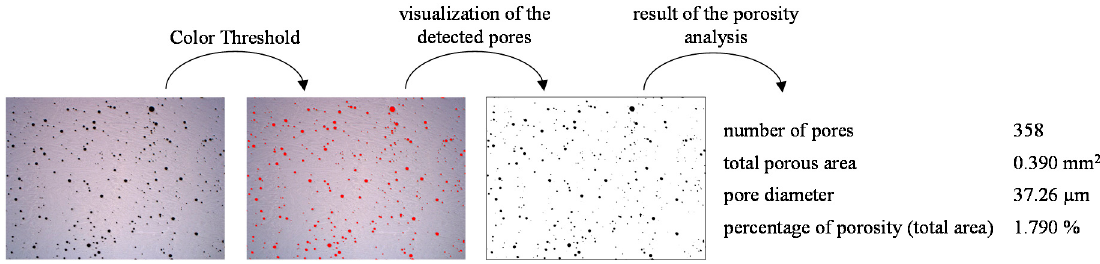
Figure 5. Exemplary representation of the process of porosity analysis.